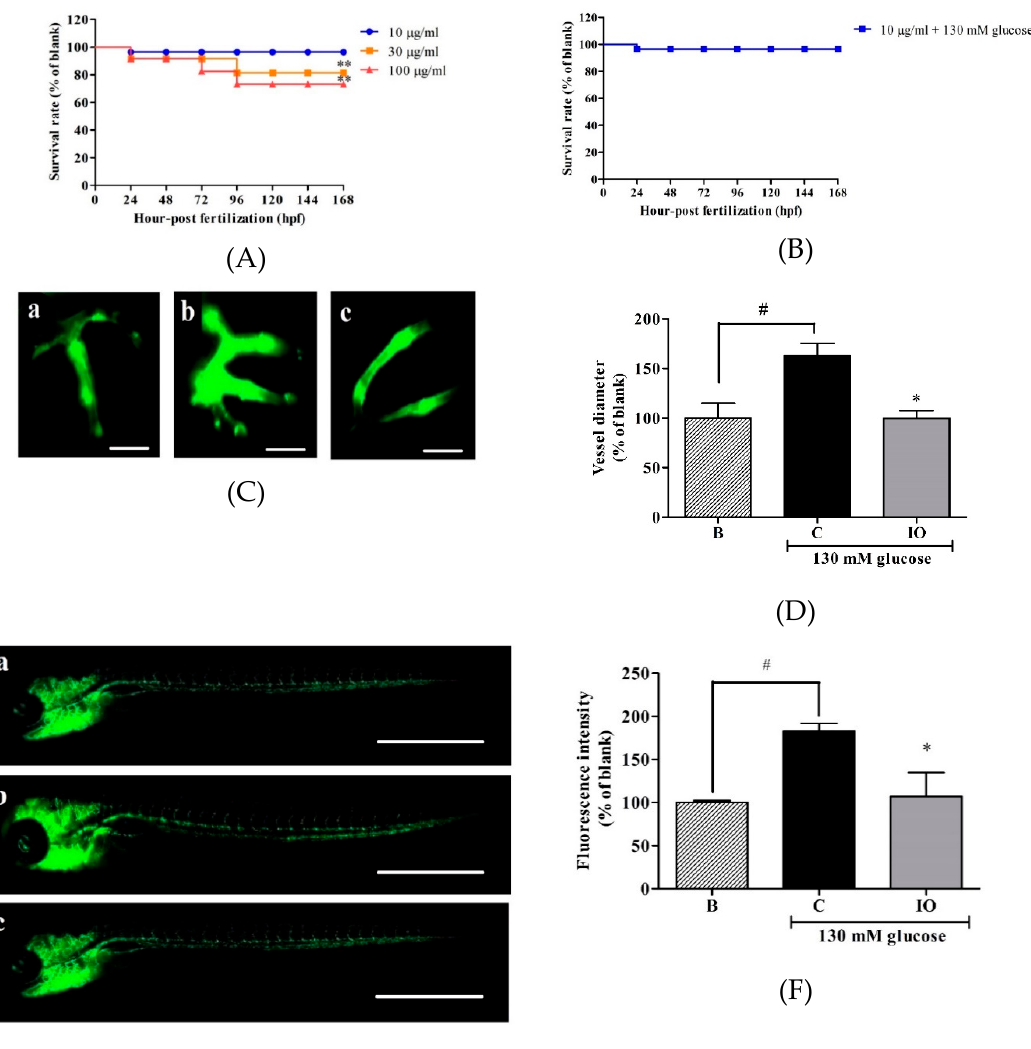
Figure 1. Effects of Ishige okamurae (IO) extract on zebrafish embryo. ( A ) Effects of IO extract on the survival rate of transgenic zebrafish ( flk :EGFP) embryos. The embryos were treated with 10, 30, and 100 µg/mL of IO extract for 24, 48, 72, 96, 120, 144, and 168 h post fertilization (hpf). The treatment effects were normalized to blank (0 µg/mL IO extract). ( B ) The survival rate of transgenic zebrafish (flk:EGFP) embryos treated with 10 µg/mL IO extract and 130 mM glucose together. ( C ) Fluorescence microscopic images of the retinal vessels of transgenic zebrafish ( flk :EGFP) embryos treated with IO extract. ( D ) The diameter of the hyaloid retinal vessel treated with IO extract. ( E ) Images of the whole body vessel formation in transgenic zebrafish ( flk :EGFP) embryos treated with IO extract as obtained by fluorescence microscopy. ( F ) Quantified fluorescence intensity of the whole body treated with IO extract (a: 0 mM glucose + 0 µg/mL IO, b: 130 mM glucose + 0 µg/mL IO, and c: 130 mM glucose + 10 µg/mL IO). The effects of 130 mM glucose on vessel formation were compared with B (blank (0 mM glucose + 0 µg/mL IO extract)). The effects of Ishophloroglucin A (IPA) on high glucose-induced vessel formation were normalized to C (control (130 mM glucose + 0 µg/mL IO extract)). Scale bar (C) 20 µm, (E) 1000 µm. * p ˂ 0.05, # p ˂ 0.05.